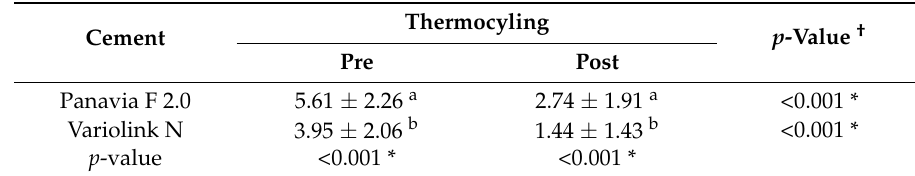
Table 3. Means and standard deviation of shear bond strength for each resin cement before and after thermocycling (MPa).